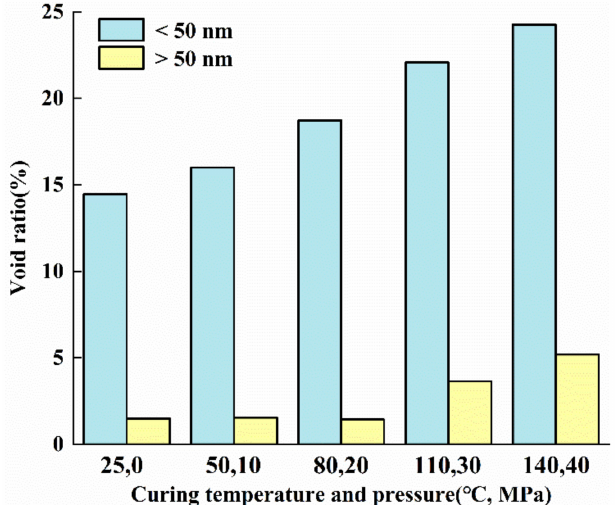
Figure 14. Void ratio of cement stone under different curing temperatures and